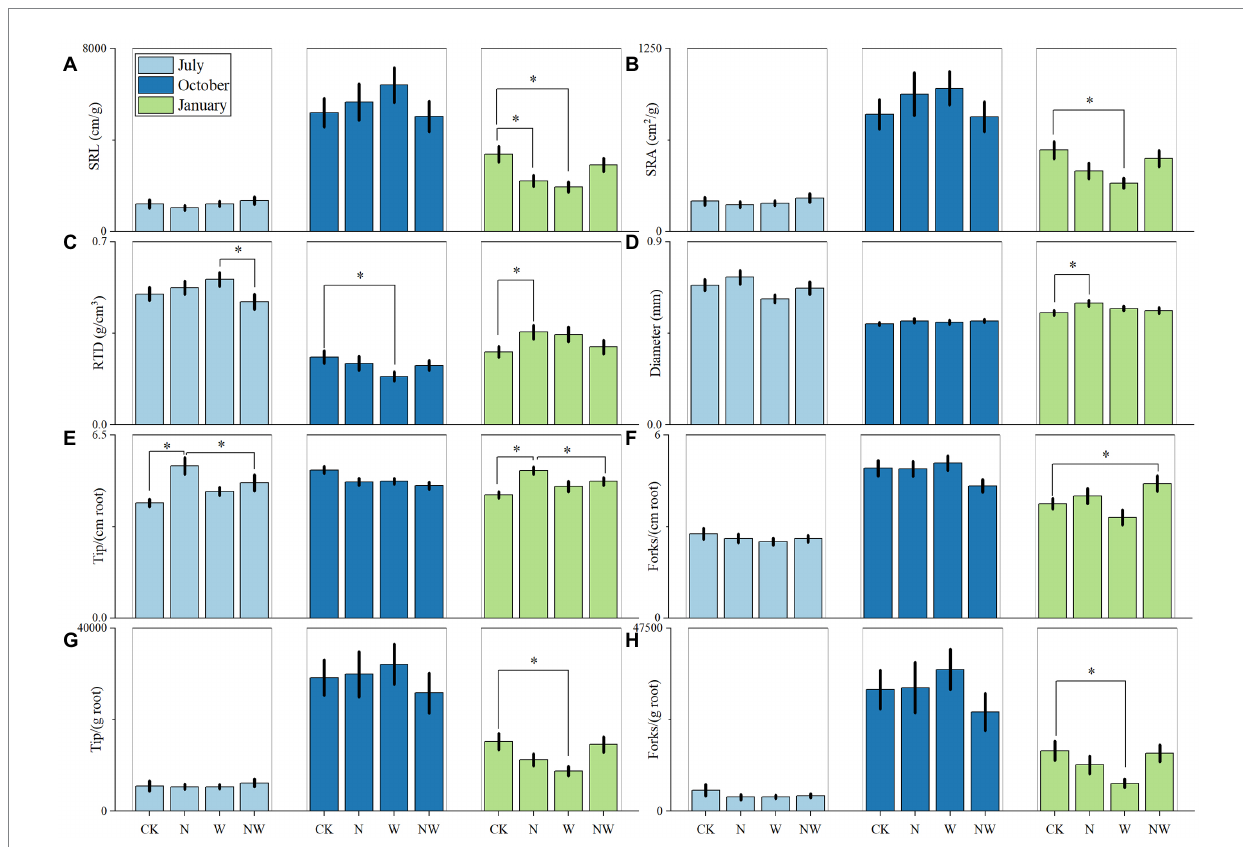
FIGURE 2 Effects of the treatments on specific root length (SRL); (A) , specific root surface area (SRA); (B) , root tissue density (RTD); (C) , diameter (D) , root tip density (E) , root branching density (F) , specific root tip density (G) , and specific branching density (H) in July 2018, October 2018, and January